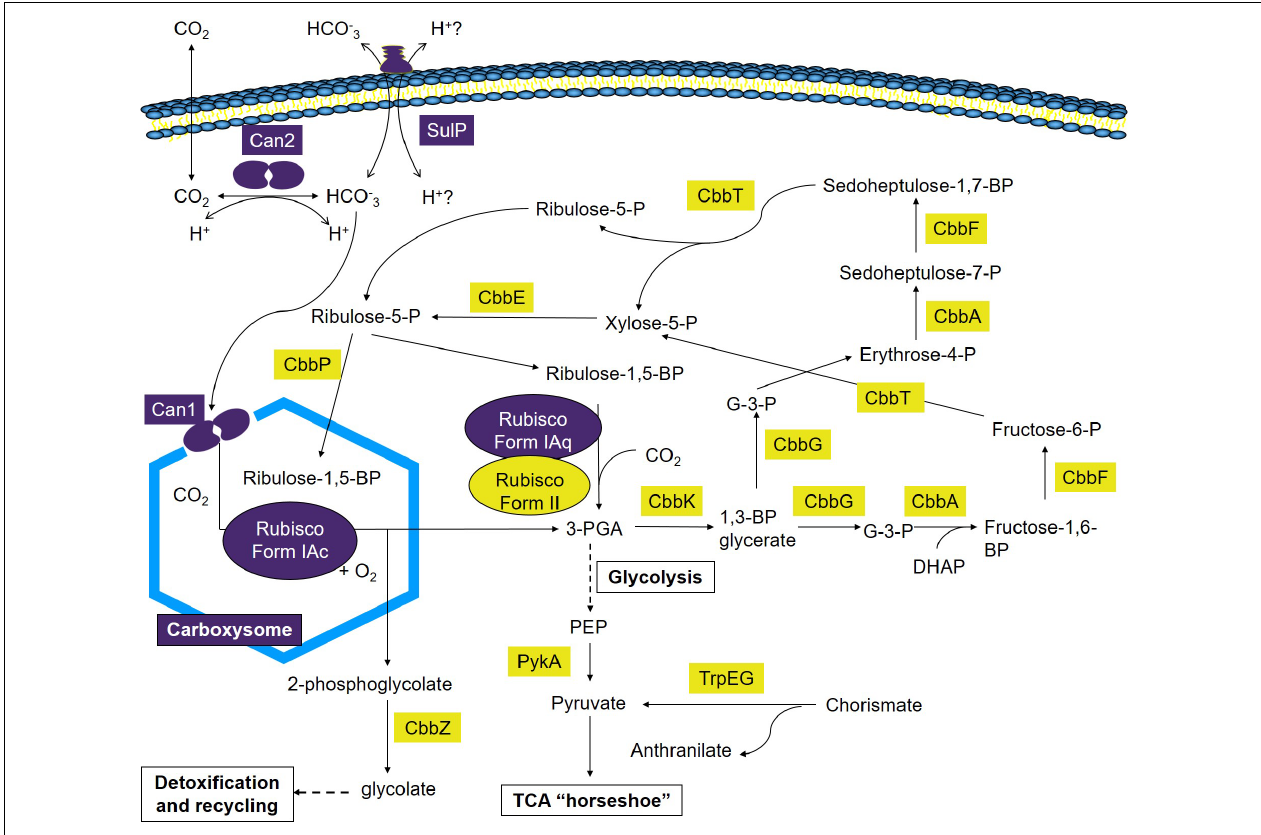
FIGURE 6 | Model of Ci uptake and assimilation in A. ferrooxidans . Predicted genes and complexes involved in Ci uptake and assimilation are color coded where purple = genes and complexes with fewer RNA transcripts in cells grown at 2.5% CO 2 versus air (O.036% CO 2 ) and yellow = genes with an increase in transcript abundance in cells grown at 2.5% CO 2 versus air (O.036% CO 2 ). 1,3-BP glycerate, 1,3-bisphosphoglycerate; Fructose-1,6-BP, fructose-1,6-bisphosphate; Fructose-6-P, fructose-6-phosphate; G-3-P, glyceraldehyde-3-phosphate; 3-PGA, 3-phosphoglycerate; Ribulose-1,5-BP, ribulose-1,5-bisphosphate; Ribulose-5-P, ribulose-5-phosphate; Erythrose-4-P, Erythrose-4-phosphate; Sedoheptulose-7-P, sedoheptulose-7-phosphate; Sedoheptulose-1,7-BP, sedoheptulose-1,7-bisphosphate; Xylose-5-P, xylose-5-phosphate; PEP, phosphoenol pyruvate; DHAP, dihydroxyacetone